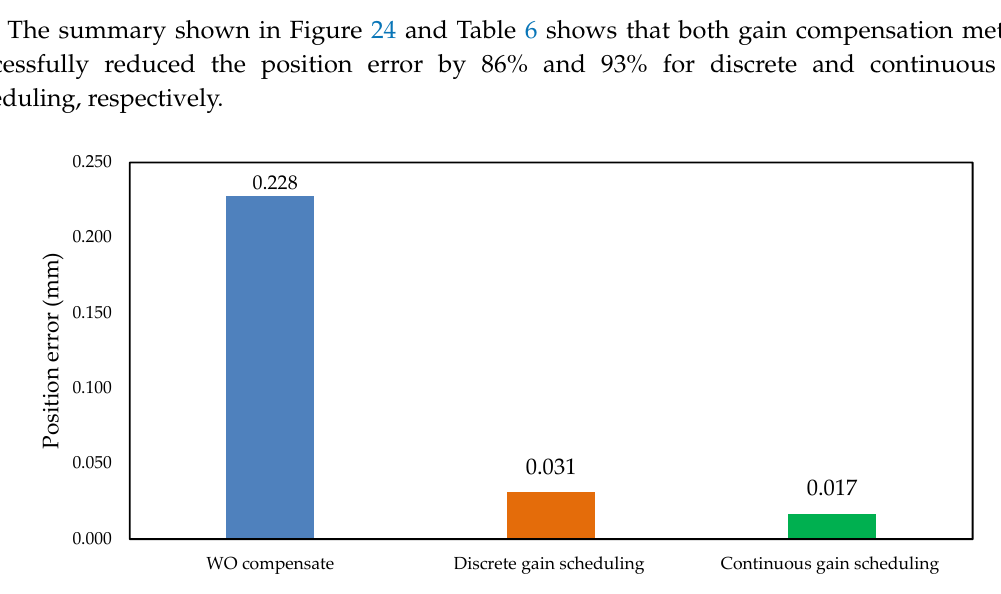
Figure 24. Comparison of systems with and without gain compensation.